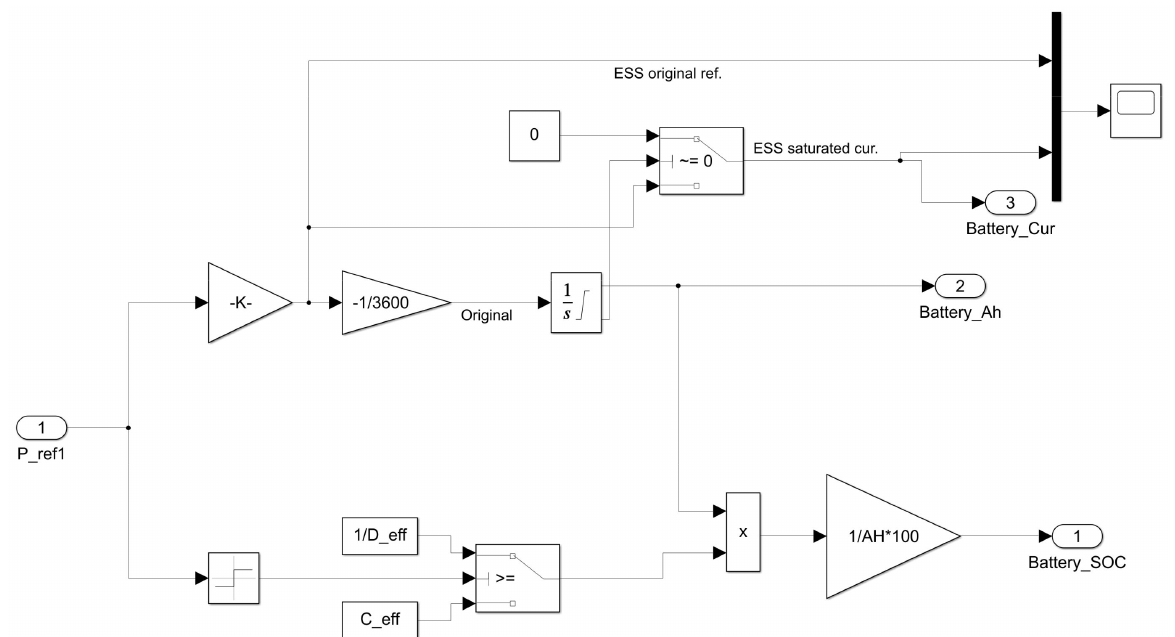
Figure 3. The description module of the BESS charging/discharging behaviors and SOC constraints.